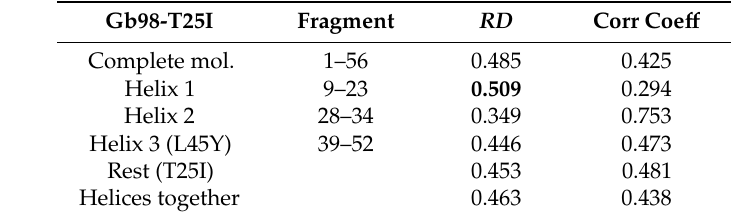
Table 4. List of parameters characterizing the status of the whole Gb98-T25I protein and the highlighted sections representing a specific secondary structure. Bold— RD status di ff erent from idealized (discordant fragment).